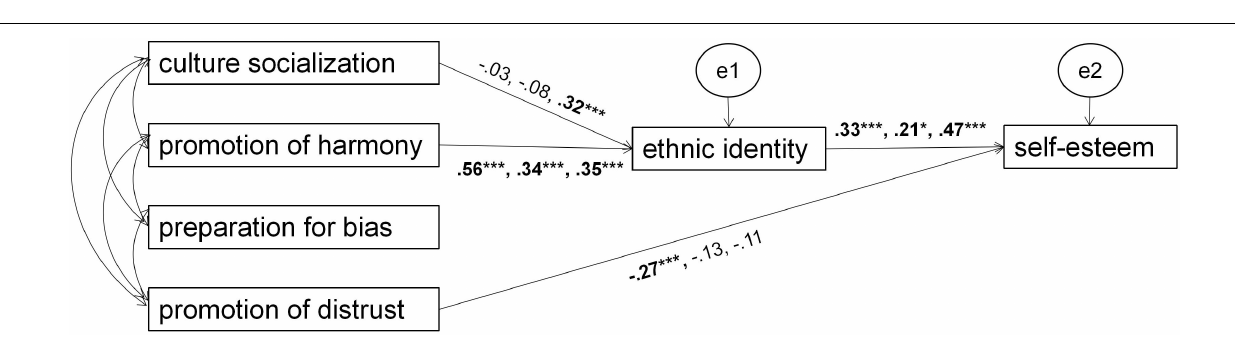
Frontiers in Psychology |